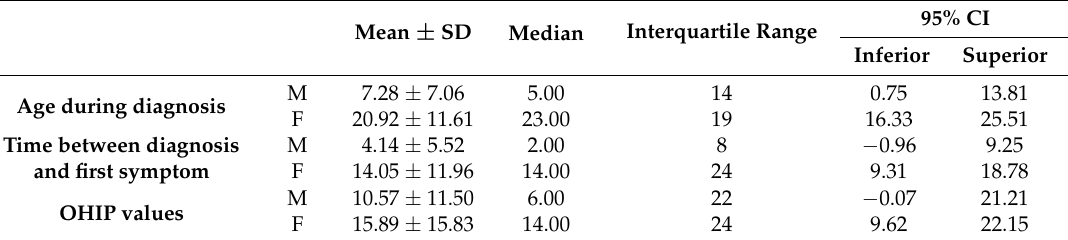
Table 1. Descriptive statistics.